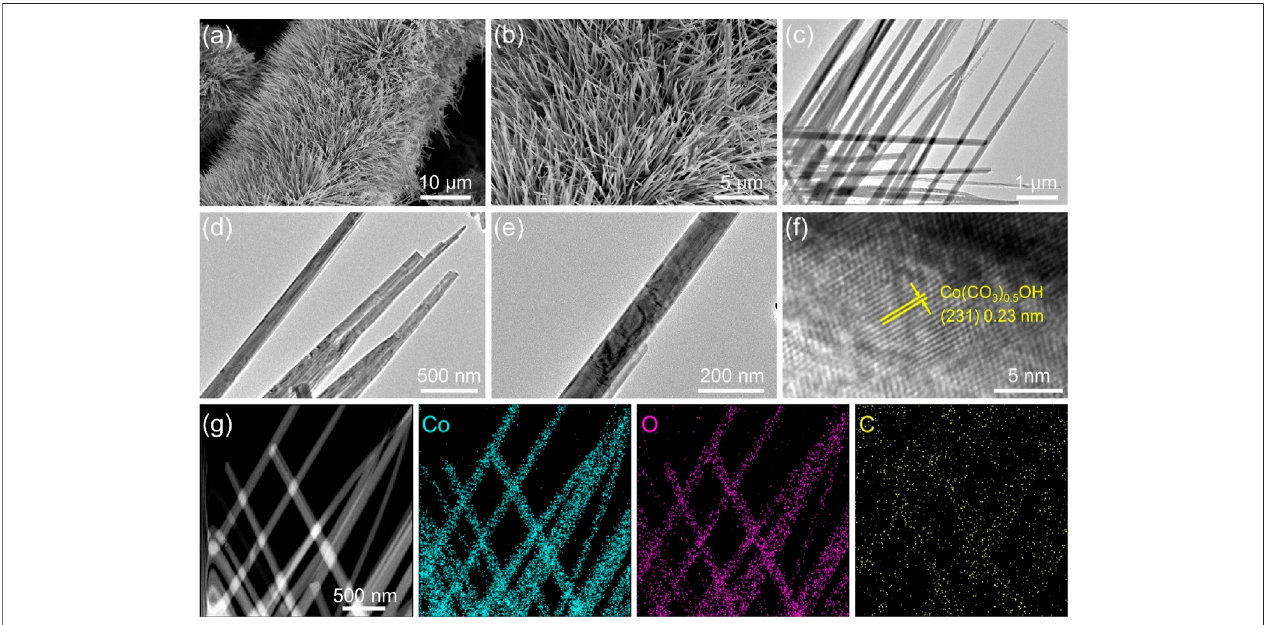
FIGURE 3 | (A , B) SEM images of Co(CO 3 ) 0.5 OH@CC nanoarrays at different magni fi cations; (C – E) TEM images of Co(CO 3 ) 0.5 OH nanoneedles at different magni fi cations; (F) HRTEM image of Co(CO 3 ) 0.5 OH nanoneedle; (G) STEM image and EDX element mappings of Co(CO 3 ) 0.5 OH